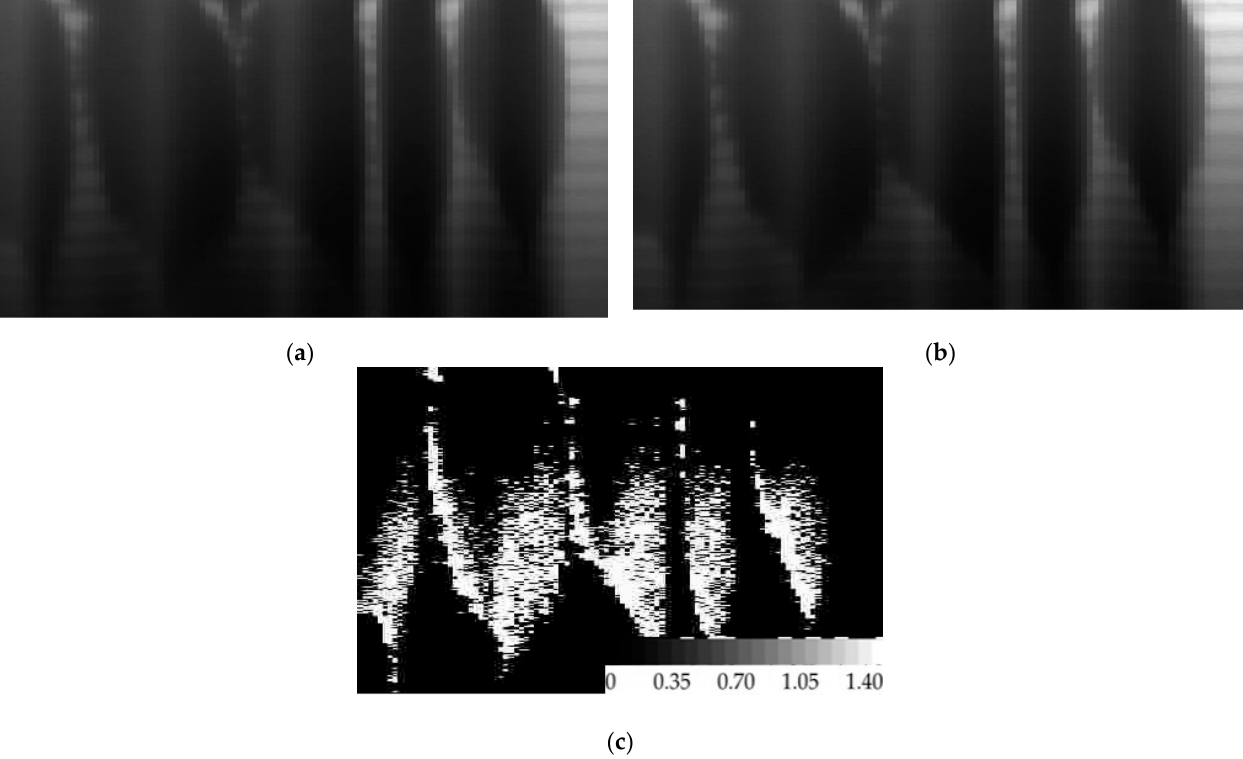
( b ) Figure 12. Leaves of ( a ) elm and ( b ) linden were used in the experiment.